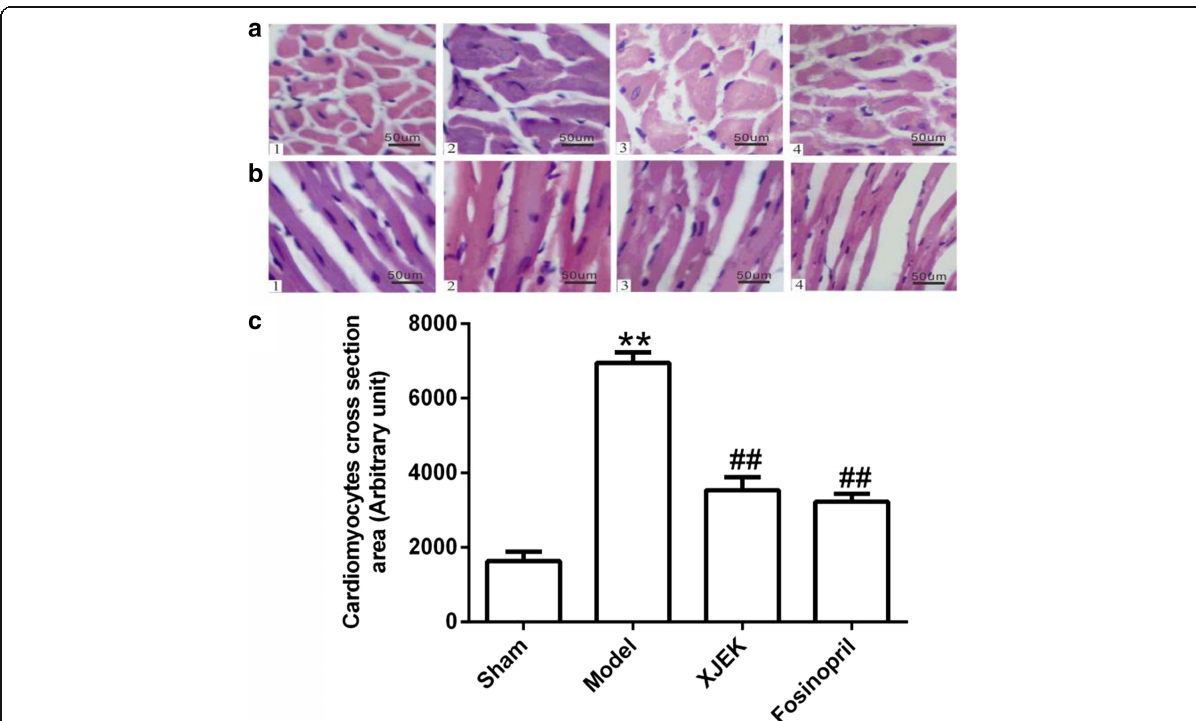
Fig. 3 Effect of XJEK on cardiomyocyte CSA and cardiomyocyte long axis of MI mice (HE stain, magnification × 400). a Representative images of histological section of cardiomyocyte cross-section (HE staining, magnification × 400); b Representative images of histological section of cardio- myocyte long axis (HE staining, magnification × 400); c Quantitative analyses results (mean ± SEM, n = 6 – 9). (1)Sham group; (2) Model group; (3) XJEK group; (4) Fosinopril group. * P < 0.05, ** P < 0.01 vs. Sham group; # P < 0.05, ## P < 0.01 vs. Model